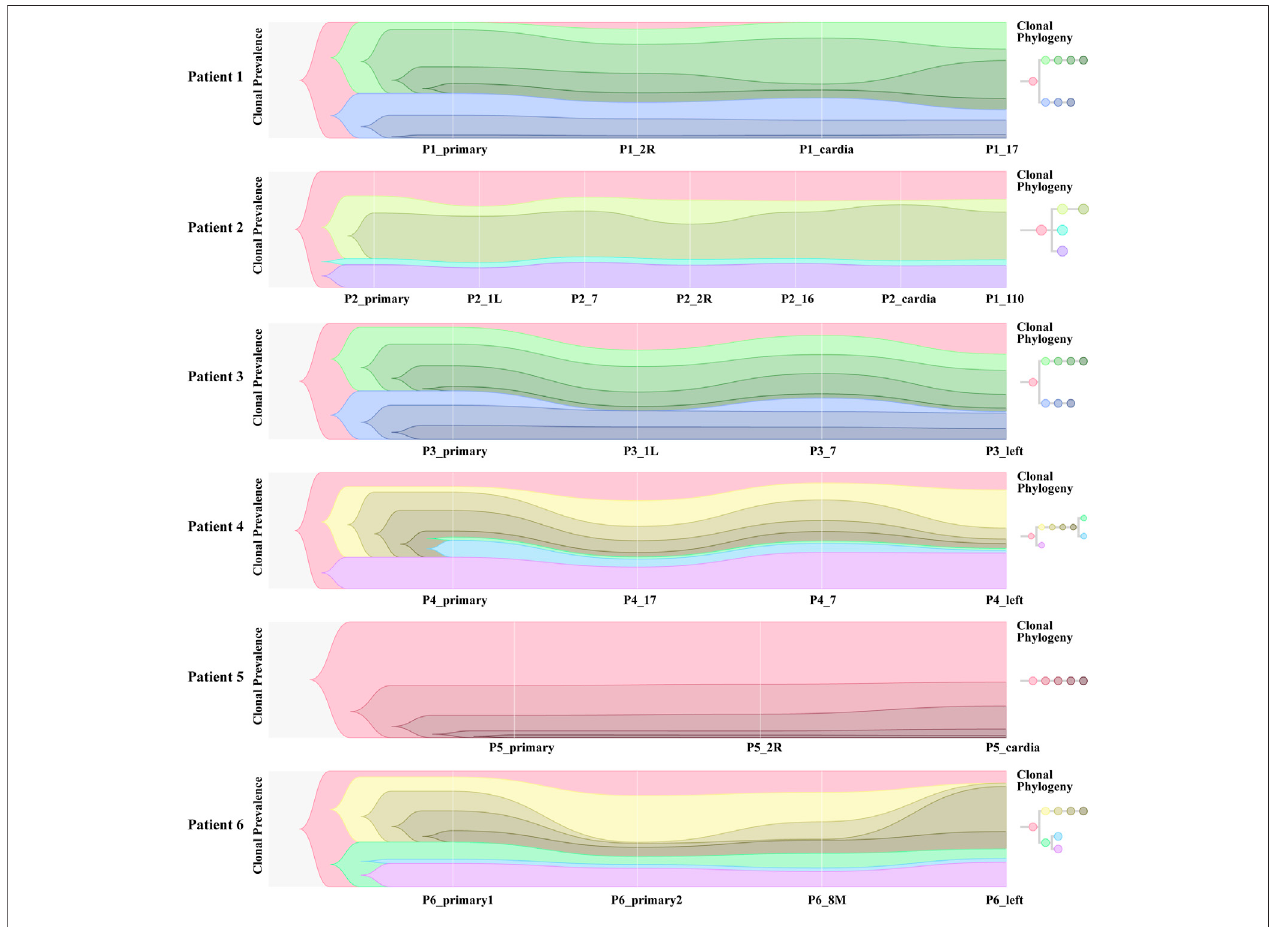
FIGURE 5 | Fish diagram of each patient ’ s tumor clone